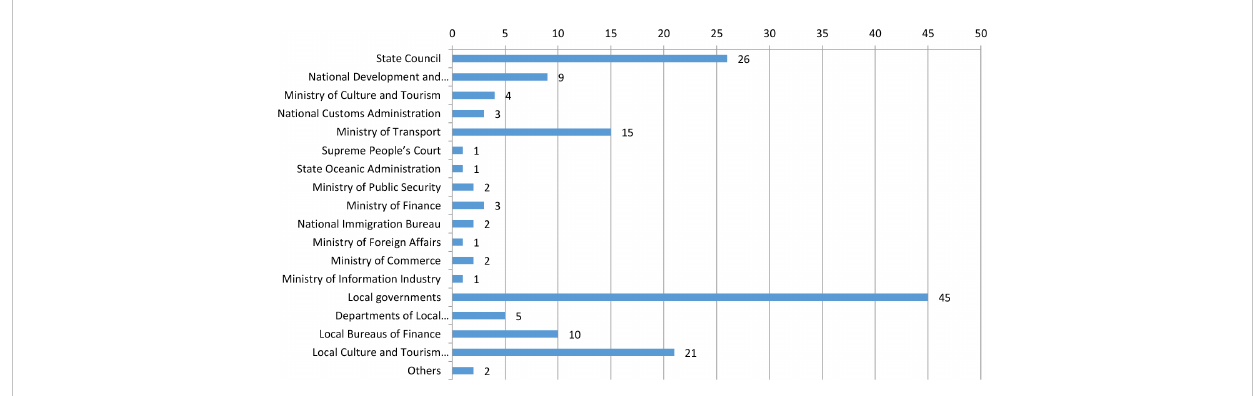
FIGURE 5 Statistics of policies by central and local government